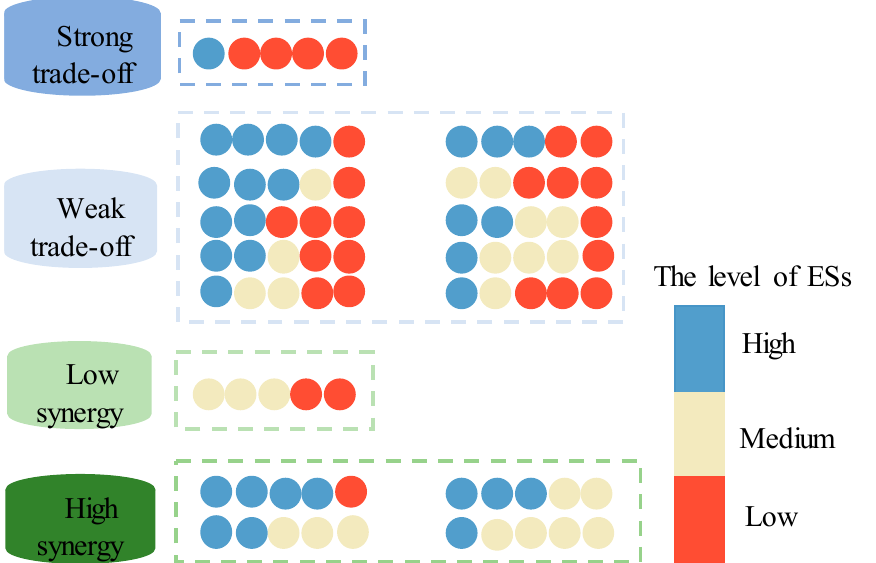
Figure 3. Schematic diagram of ES trade-offs/synergy analysis. Each circle represents a type of ecosystem service. The circle has no fixed position and can be changed in order. Considering that there are many types of overlay, only the five types of ecosystem services appearing in this article are listed. The order of the circles in different colors reflects the superposition of different levels of ecosystem service types.